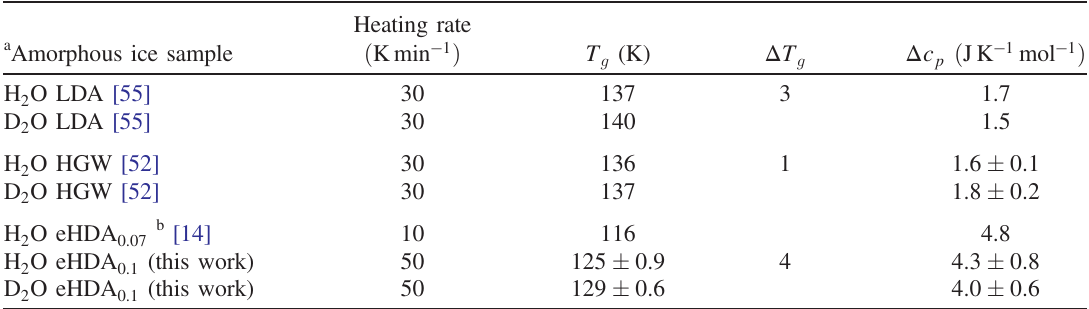
TABLE II. Onset glass transition temperatures ( T ) at the glass transition for different H 2 O and D 2 O amorphous heat capacity ( Δ c p